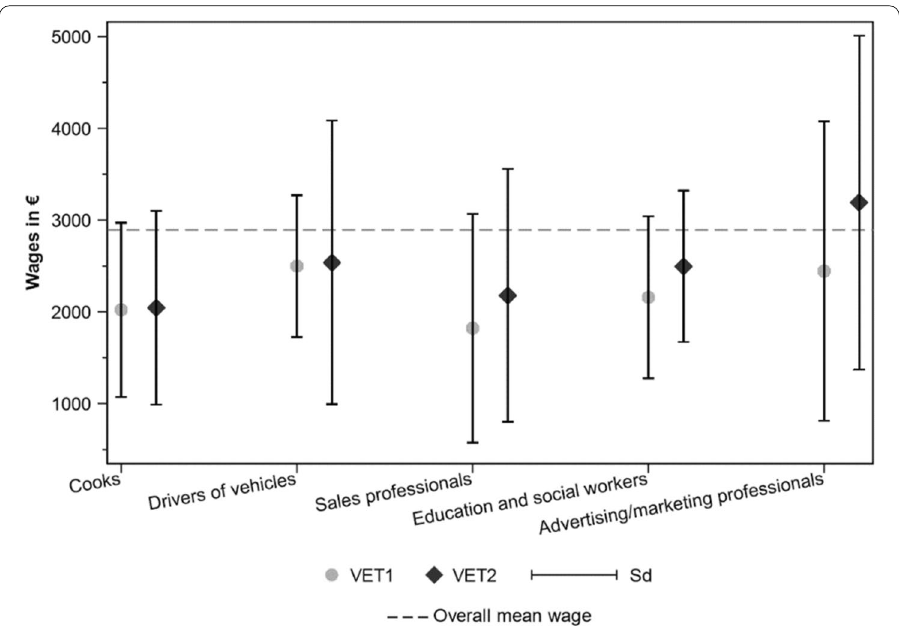
Fig. 2 Means and standard deviations of wages in selected occupations (Source: BIBB/BAuA Employment Survey 2018, weighted values. Population: German